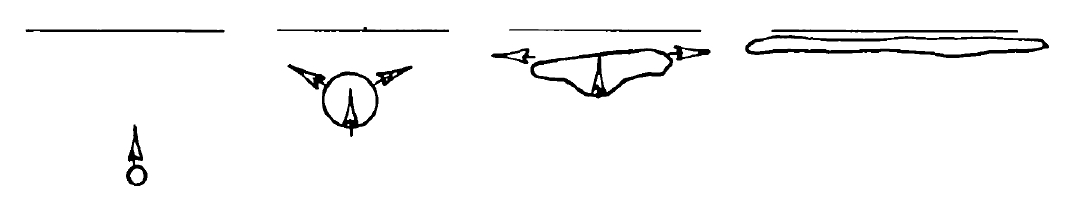
Figure 7: Figure from Spruit et al. (1987) illustrating the conjectured behavior of a buoyant flux tube as it approaches the photospheric base (indicated by the flat horizontal line) from below. The arrows indicate the direction of plasma motion. The severe change in aspect ratio of the tube’s cross-section is due to the diminishing pressure scale height at the top of the convection zone. This predicted behavior is a robust result in numerical MHD simulations of emerging flux. Image reproduced with permission, copyright by